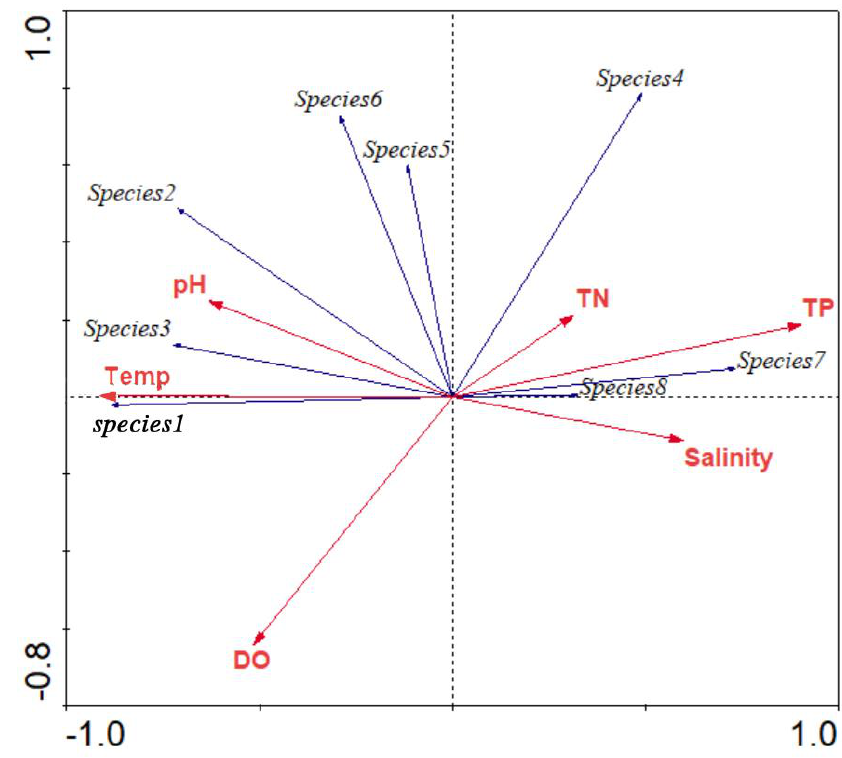
Figure 6. RDA between phytoplankton and environmental factors.